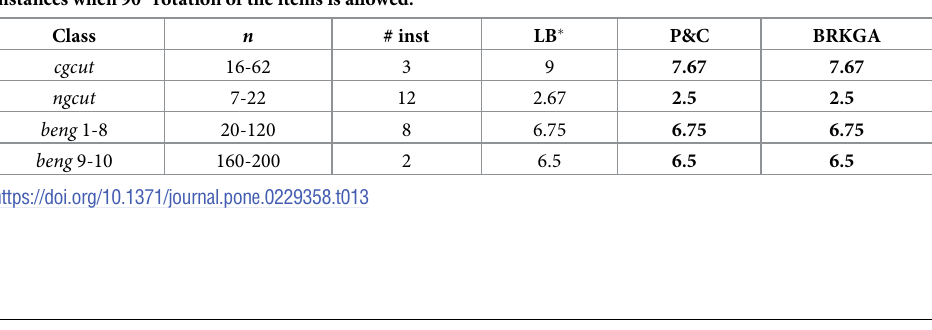
only present the comparisons of the P&C methodology (enhanced by Eqs (7) and (8)) with the other ones. Table 12 shows the results for the bwmv instances when 90˚ rotation of the items is allowed. The structure of this table is similar to Table 10, but we only compare ourselves against the BRKGA, HHA-NO(r), HHA-NO(sr), and SVC2BPRF approaches, since they are the only ones that present solutions with rotations by 90˚ of the items. The lower bounds (LB) for this table were obtained from [40] We can observe a reduction in the number of bins in contrast with the results of Table 10 (without rotations) and with the lower bound obtained in the literature for the non-rotation case. Also, the P&C could solve the instances up to Class 3 with 20 items. For 40 items, our methodology only solved 9 out of 10. With these results, we have validated that the heuristical solutions of [2] are indeed the optimal ones. Recall that the number of valid positions, and therefore the number of variables in the P&C set-covering formulation can almost double when rotation is allowed. Thus, these instances are harder to solve by our exact methodology. Table 13, similar to Table 11, shows the comparison results of the P&C methodology for the cgcut , ngcut , and beng instances against the BRKGA (the only approach from Table 9. The rota- tion of the items decreases the number of bins needed to pack all of them by improving the lower bounds obtained for the non-rotation case. We have again validated that the solutions obtained by the genetic algorithm are indeed the optimal ones for the instances that the P&C could solve.